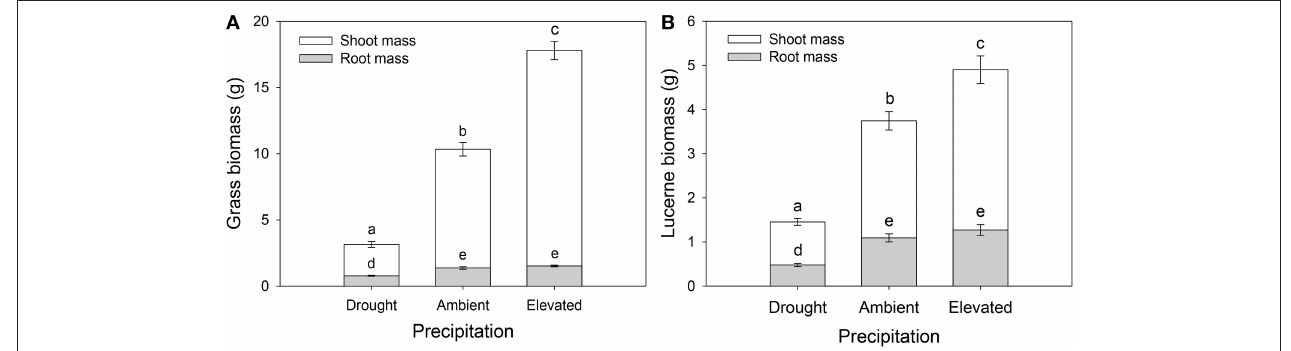
FIGURE 4 | The impacts of precipitation on the root and shoot biomass of Harding grass (A) and lucerne (B). Herbivore treatment had no significant effect on biomass. Mean values ( ± SE) are shown. Bars with the same letters were not significantly different ( P < 0.05).